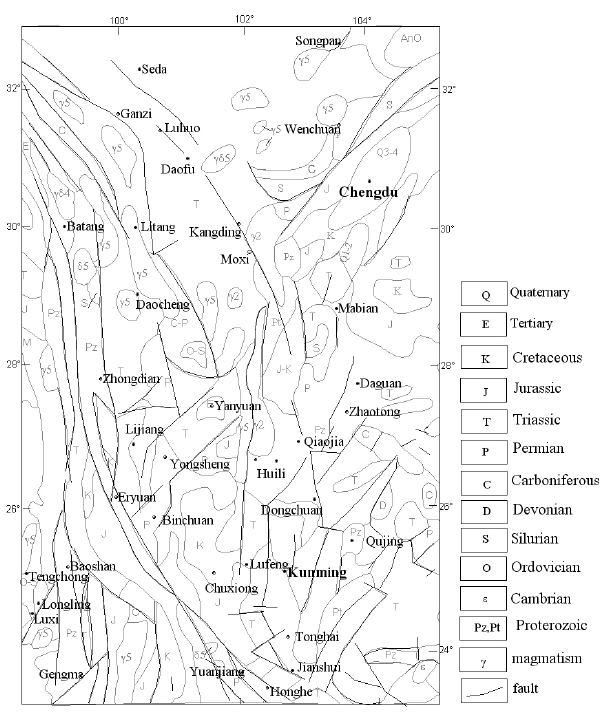
Fig 2. Geological map in southwest China Fig. 2. Geological map in southwest China (Revised from Litho- (Revised from Lithospheric dynamics atlas of China, 1989) spheric dynamics atlas of China,